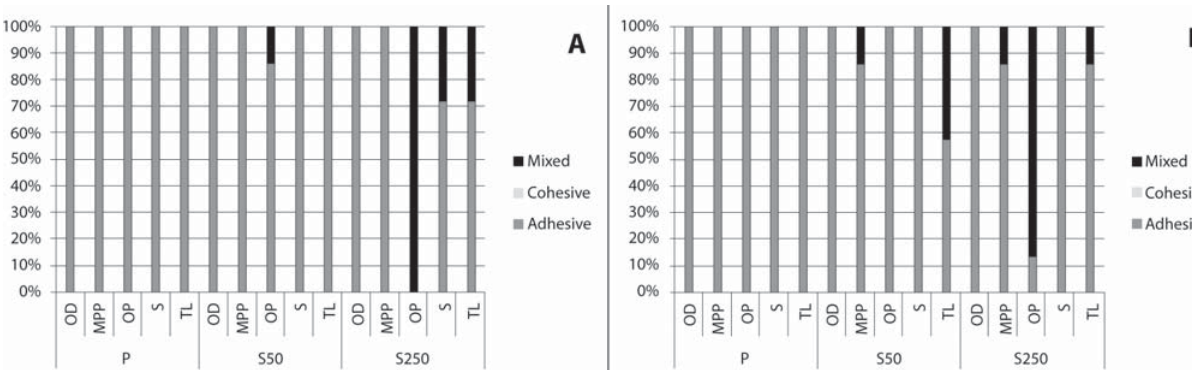
Table 2- Shear bond strength (MPa) mean values (±standard deviations) of resin composite to sandblasted cpTi surfaces with metal primers after 24 h of